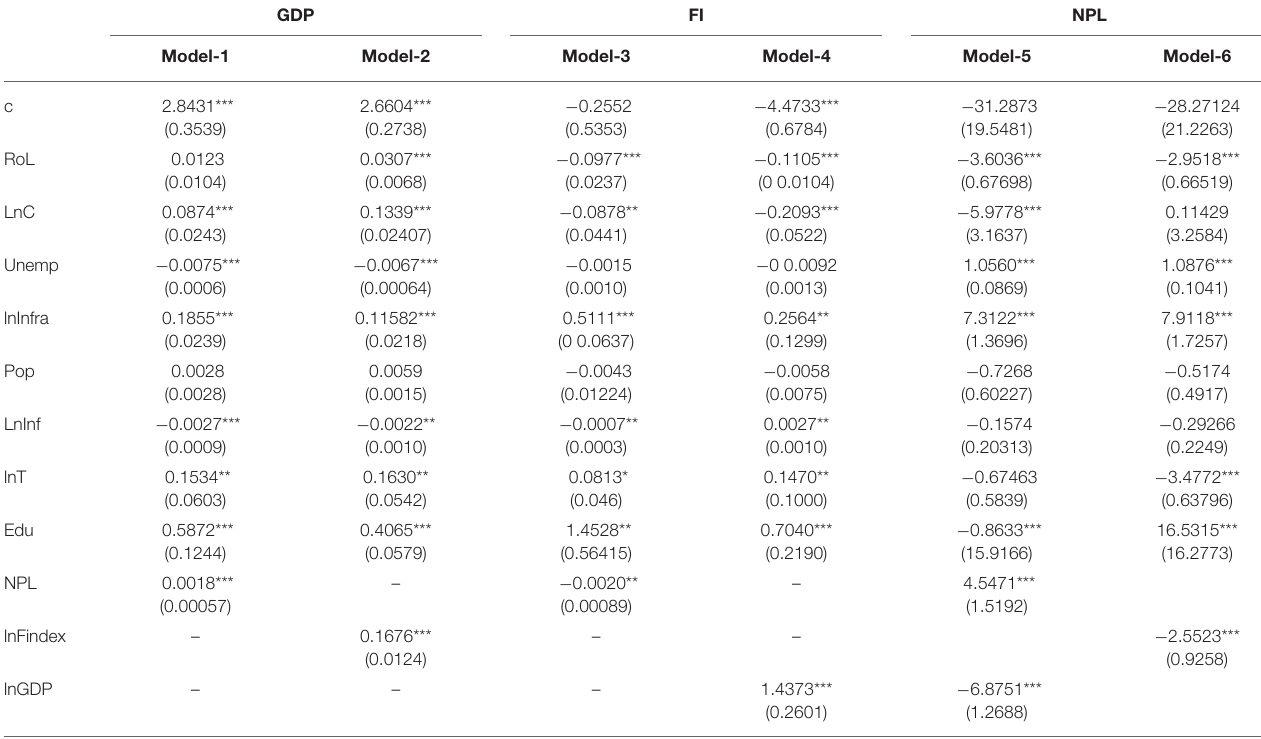
TABLE 8 | Estimation results: Driscoll-Kraay standard errors with fixed